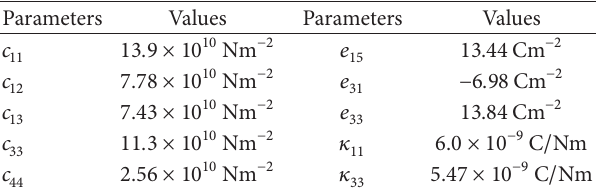
Figure 22: The variation of displacement component (a) 𝑢 1 and (b) 𝑢 2 along the right edge of the plate ( 𝑥 = 8 ) by HFS-FEM and ABAQUS. Table 3: Properties of the material PZT-4 used for the model. Parameters Values